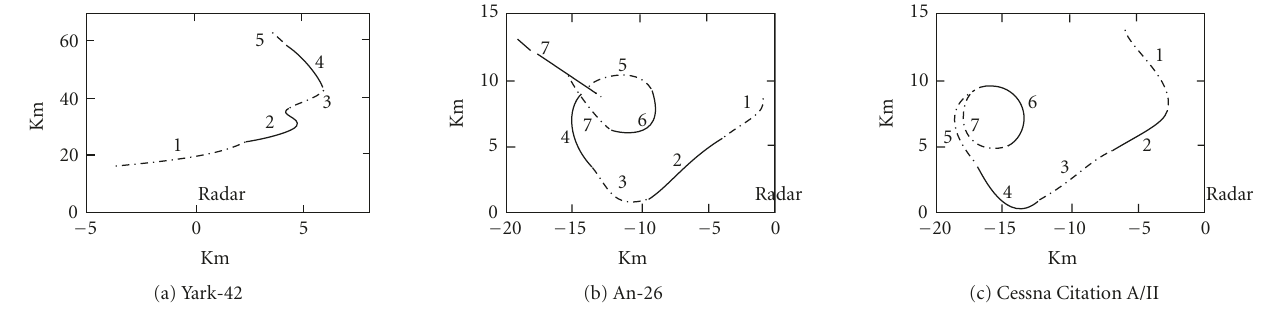
Figure 4: The projection of target trajectories onto the ground plane. (a) Yark-42, (b) An-26, (c) cessna citation S/II.